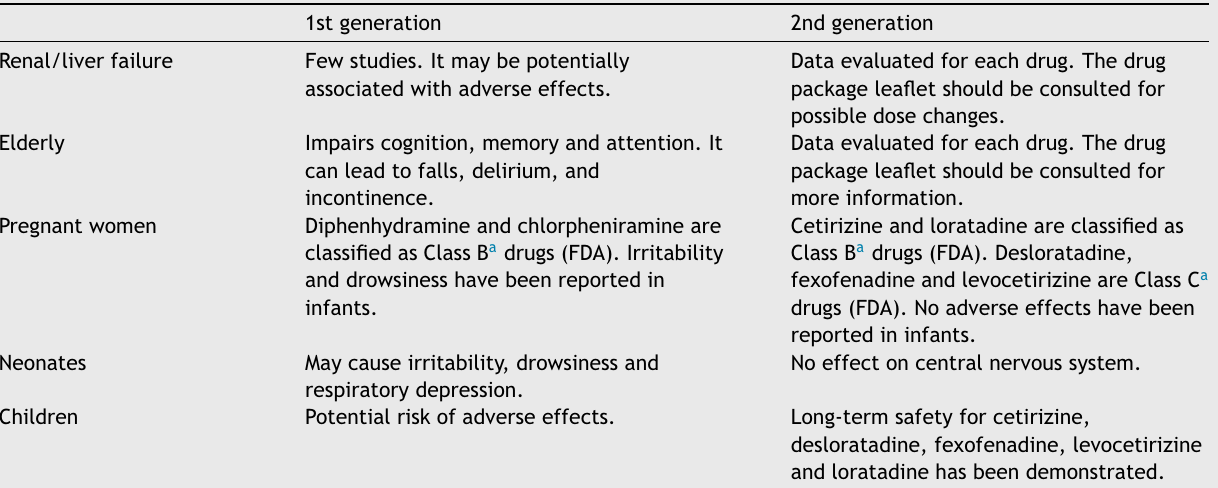
Table 7 Adverse effects in special populations. 11 1st